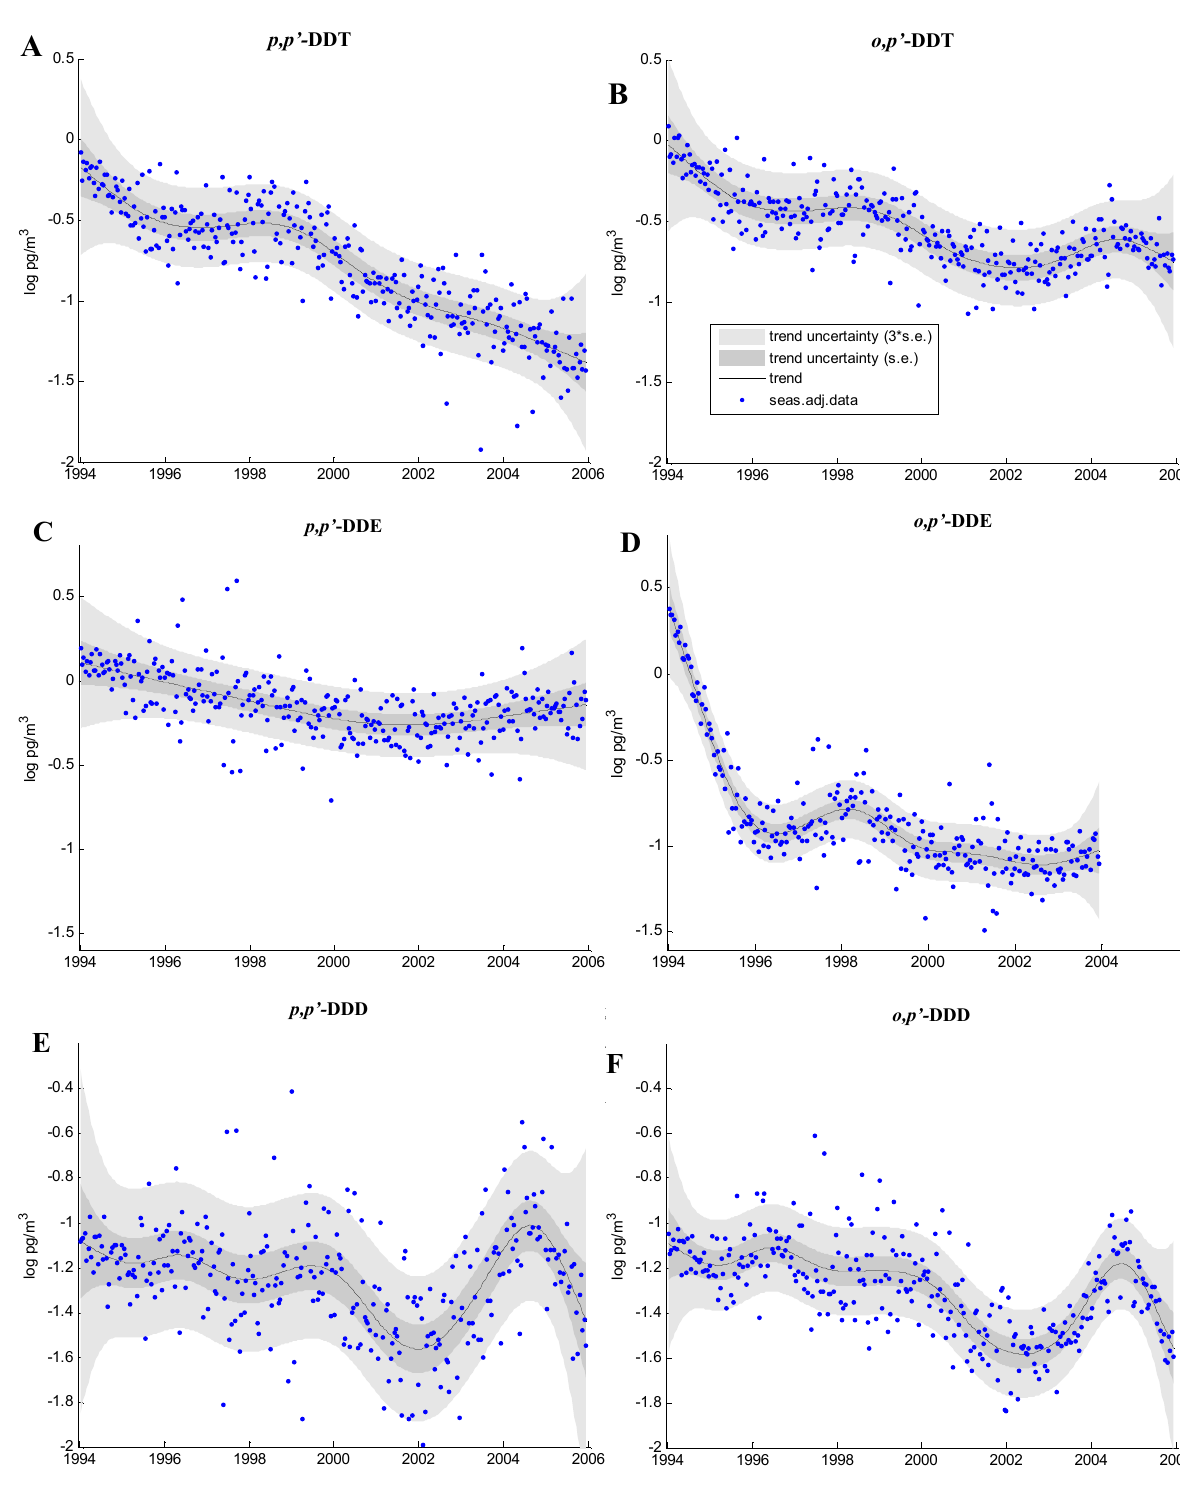
Fig. 5. Seasonally adjusted data and underlying trends for p,p 0 -DDT (A) ; o,p 0 -DDT (B) ; p,p 0 -DDE (C) ; o,p 0 -DDE (D) ; p,p 0 -DDD (E)